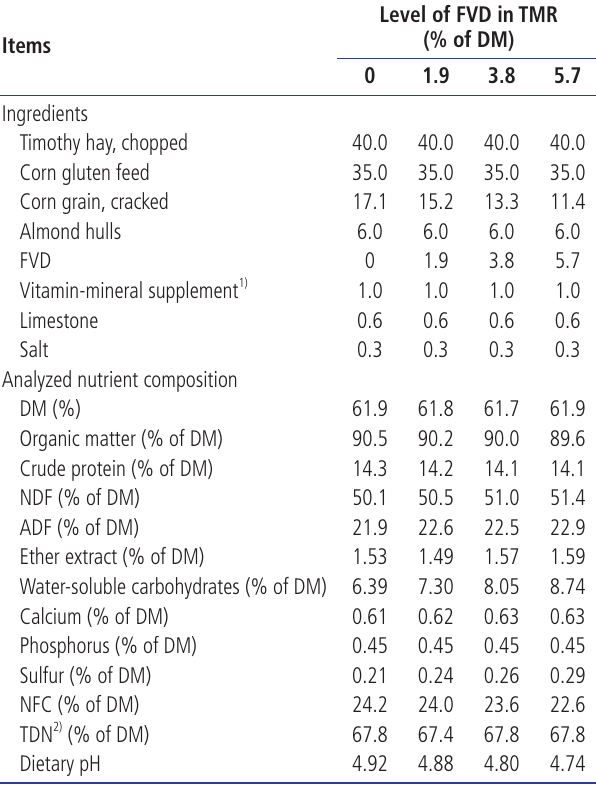
Level of FVD in TMR (% of